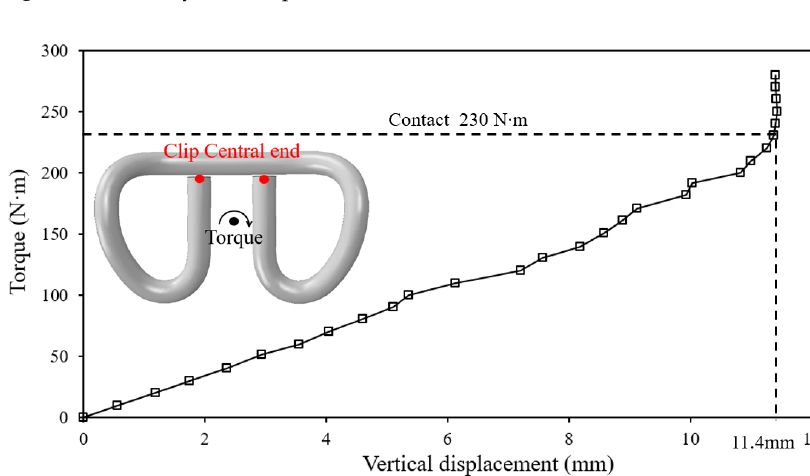
Figure 5. Global response of the clip (torque vs. vertical displacement).